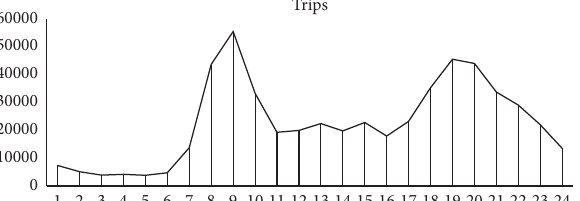
Figure 1: OFO bike service area in